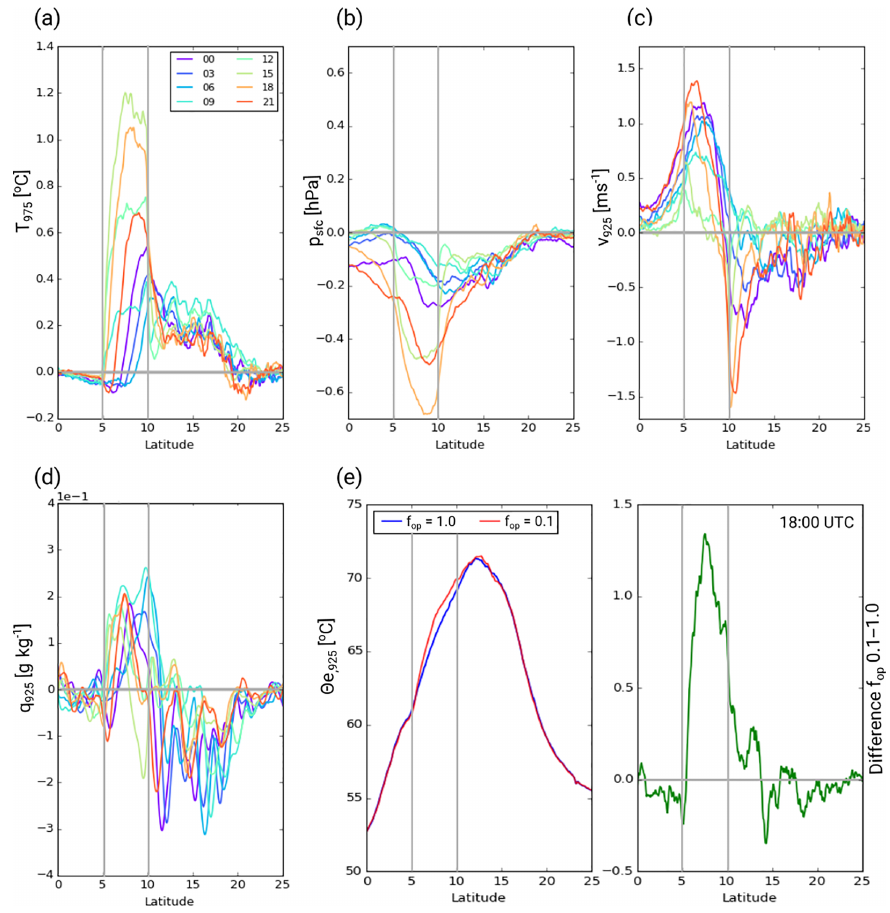
Figure 10. South–north distribution of 8 ◦ W–8 ◦ E averaged differences of ICON EXPL f op = 0 . 1 minus f op = 1 . 0 for July 2006. Coloured lines provide a 3-hourly resolution of the diurnal cycle of (a) T , (b) p sfc , (c) meridional wind v and (d) q v . In (e) absolute θ e curves and their difference are shown. Apart from p sfc and T at 975hPa, all variables are shown for